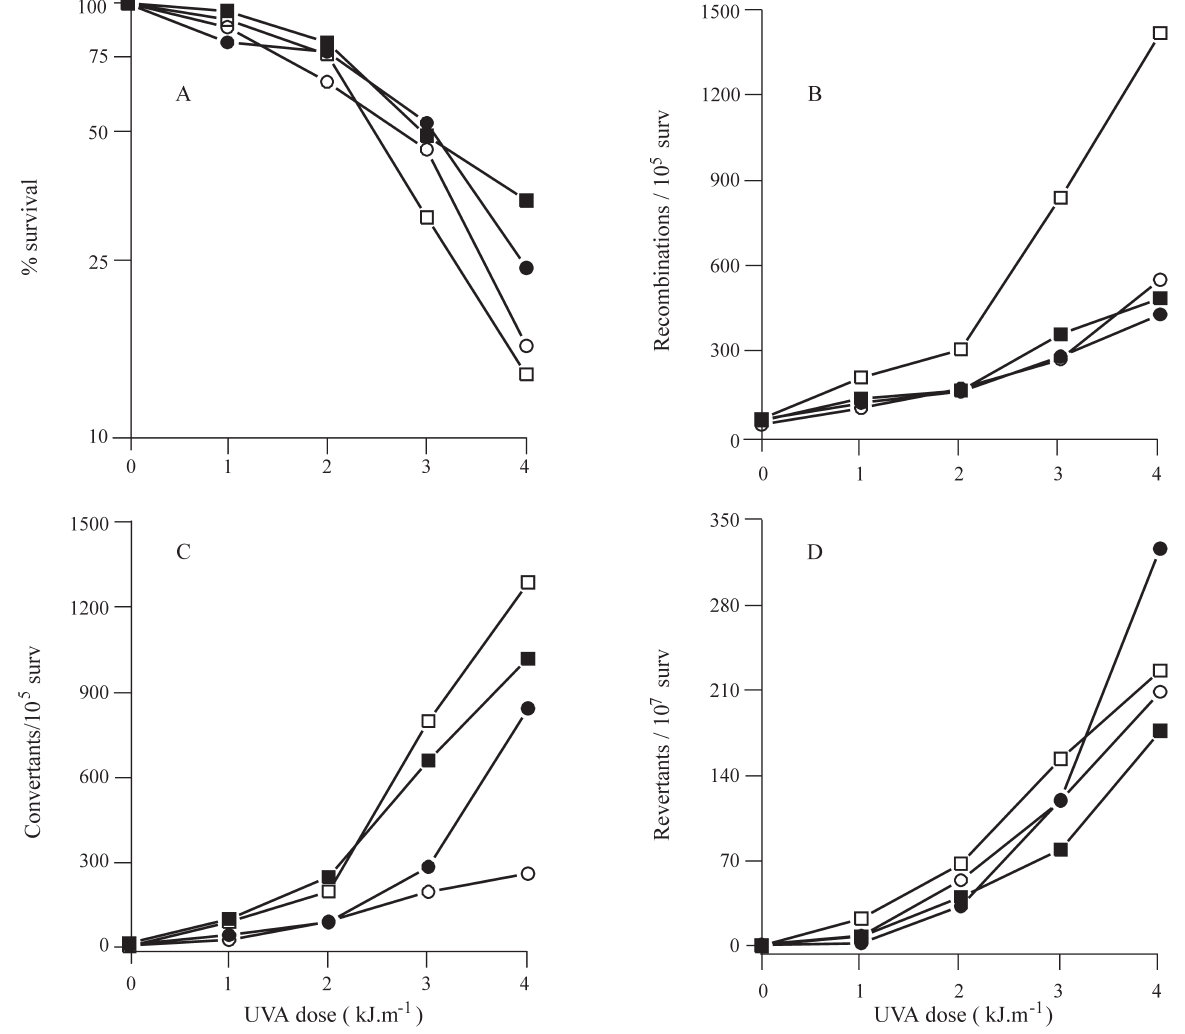
Figure 1 - Effect of recA gene expression on mitotic diploid yeast cells treated with 8-MOP+UVA. Figure A, percentage cell survival; Figure B, recipro- cal recombination; Figure C, gene conversion; Figure D, reverse mutation. Yeast transformants harboring the control pNF2 plasmid ( (cid:1) ) or pNF2 recA plasmid ( (cid:1) ) were treated in the exponential (closed symbols) or stationary (open symbols)